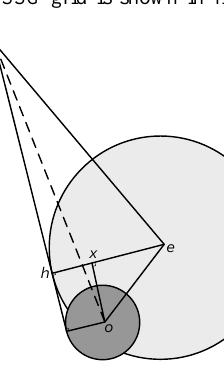
Figure 6. SDOG-ESSG blocked-data elimination strategy based on horizon culling